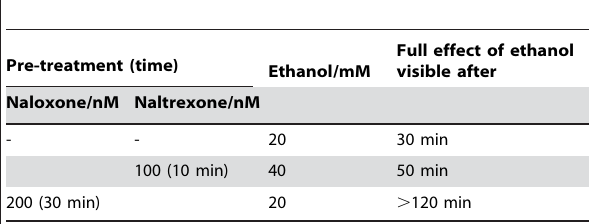
Table 2. Naloxone and naltrexone modulate the effect of ethanol on the plasma membrane lipid